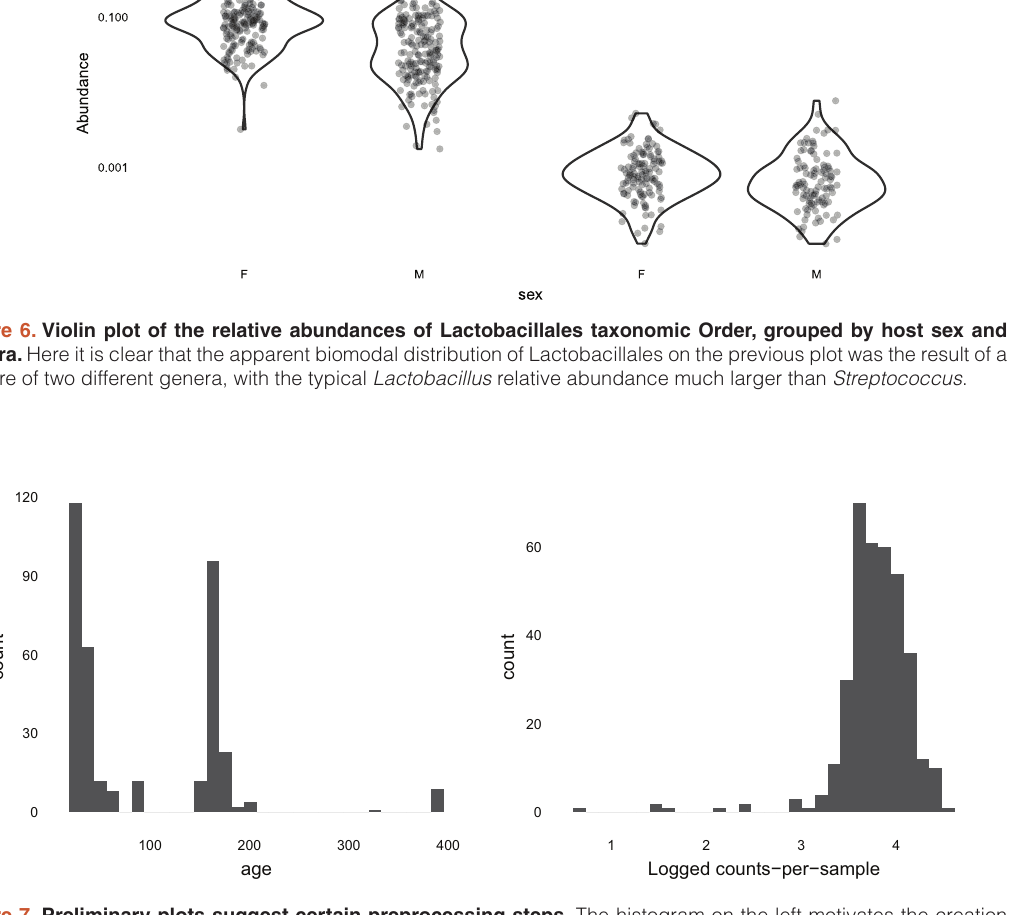
Figure 7. Preliminary plots suggest certain preprocessing steps. The histogram on the left motivates the creation of a new categorical variable, binning age into one of the three peaks. The histogram on the right suggests that a log (1 + x ) transformation is sufficient for normalizing the abundance